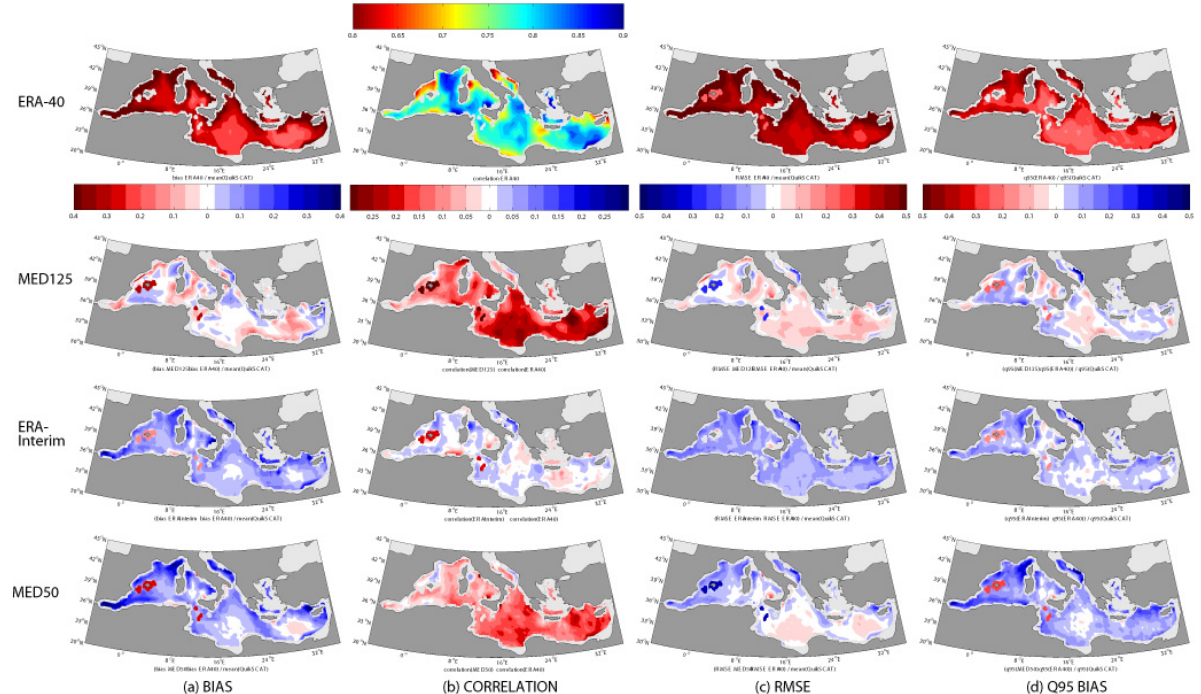
Fig. 6. First line: relative bias, correlation, RMSE and bias of the 95th percentile of the daily wind speed over 2000–2001 in ERA-40 compared with QuikSCAT. Second, third and fourth lines: relative difference between MED125, ERA-Interim and MED50 on one hand and ERA-40 on the other of the bias (a), the correlation (b) , the RMSE (c) and the 95th percentile bias (d) of the daily wind speed over 2000–2001 compared with QuikSCAT. The colorbar is the same for each map inside a given column except for the correlation, where the colorbar used for ERA-40 alone is different. Blue corresponds to an improvement (decrease of the absolute value of the negative bias and q 95 bias, increase of the correlation and decrease of the